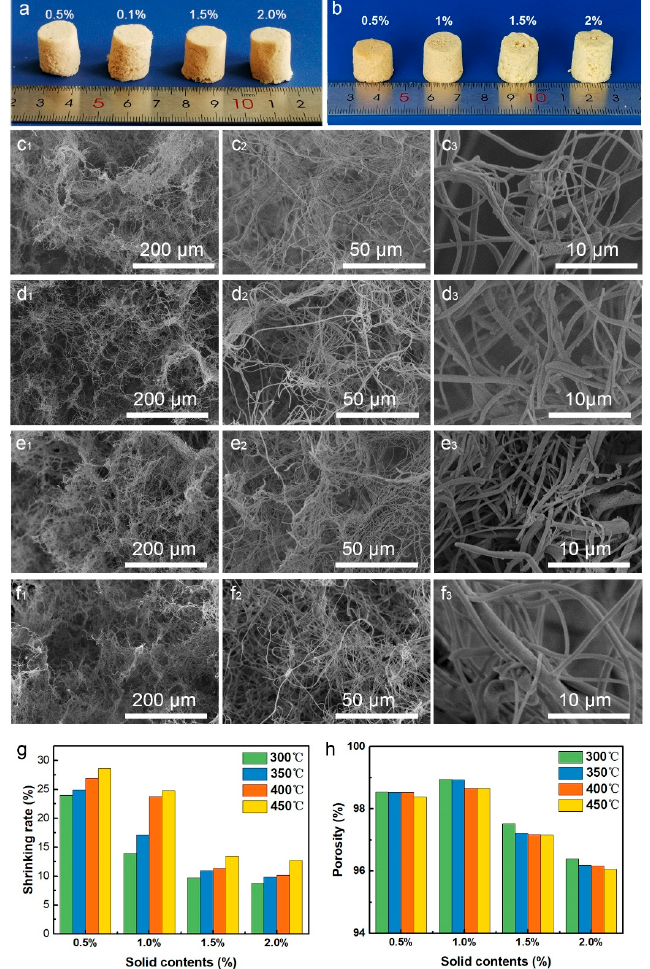
Figure 5. Photograph of un-NAs ( a ) and PI/PTFE-PAI NAs ( b ) and SEM images of PI/PTFE–PAI NAs with different fiber content; ( c 1 – c 3 ) 0.5%; ( d 1 – d 3 ) 1%; ( e 1 – e 3 ) 1.5%; ( f 1 – f 3 ) 2% as the ratios of PAA: